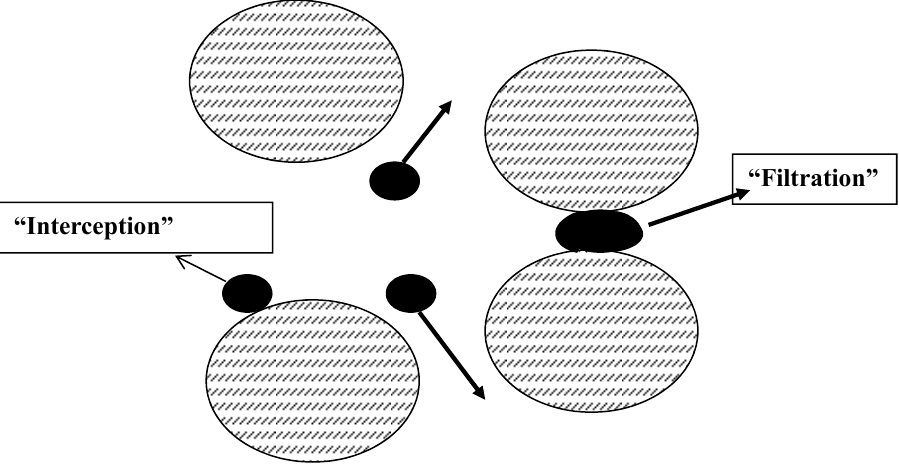
Figure 2. Proposed enhanced-oil recovery (EOR) mechanism by flow of in-situ emulsions. Water drops are represented in black. Filtration is representative of capillary trapped